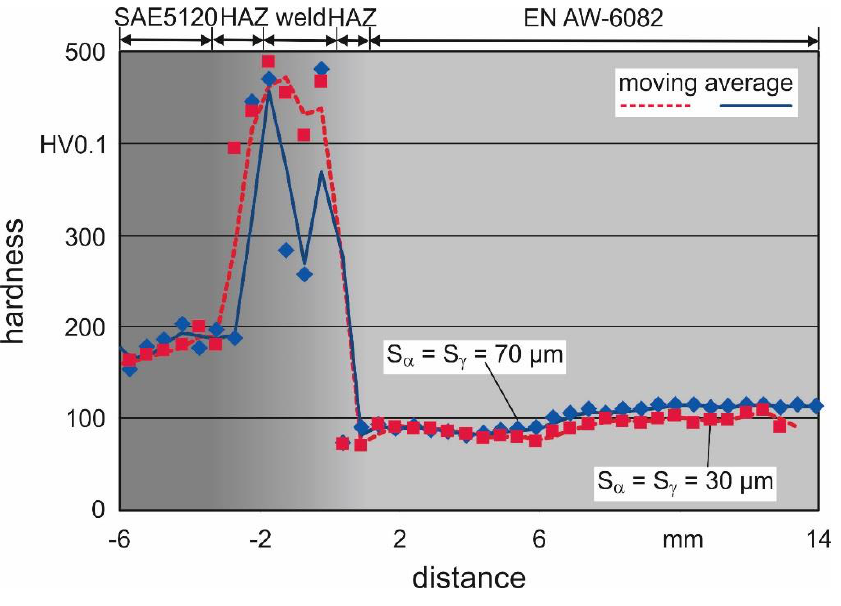
Figure 7. Hardness measurement for two different laser beam welded samples of SAE5120 and EN AW-6082.